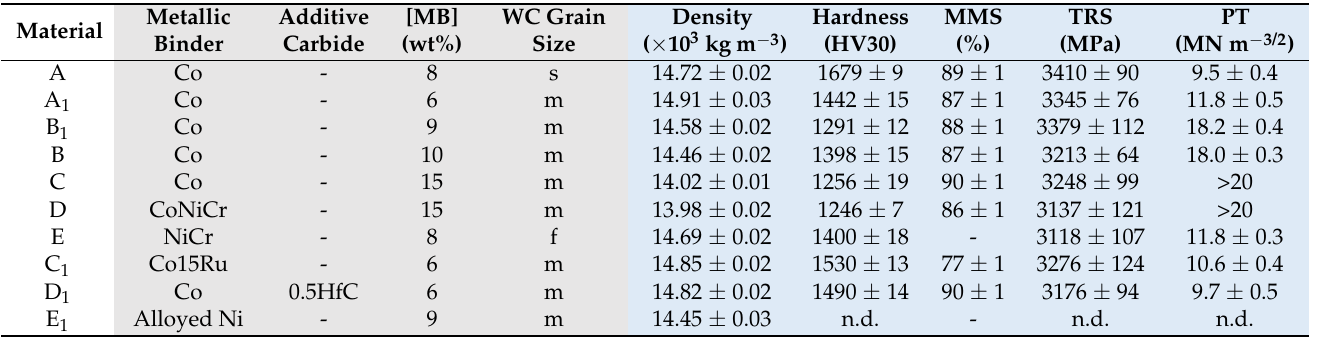
Table 1. Composition and metallurgical characterization of Co- and Ni-based grades, with Cr, Hf and Ru additions. MB: metallic binder content; MMS: relative magnetic moment at saturation; TRS: transverse rupture strength, PT: Palmqvist